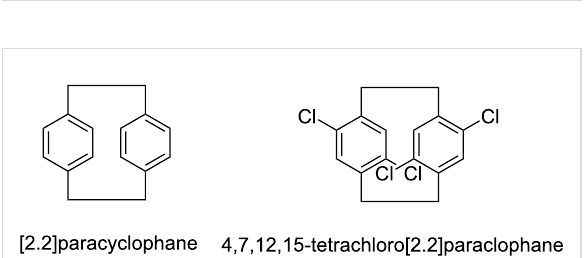
Figure 1: Chemical structures of parylene N, parylene C, and pary- lene D.